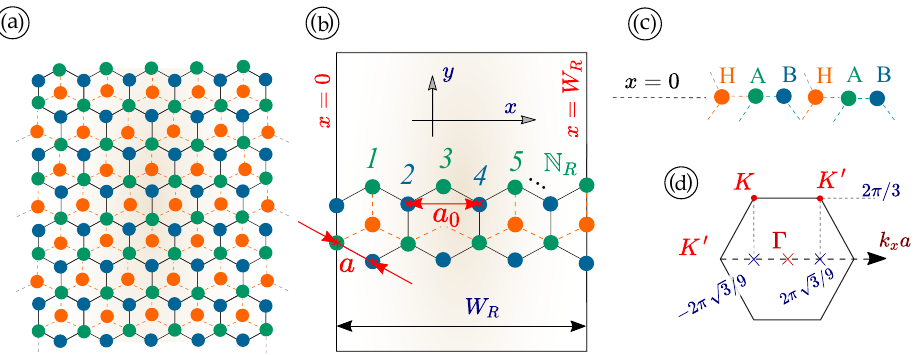
T 3 armchair nanoribbons. Panels − T 3 or a dice −